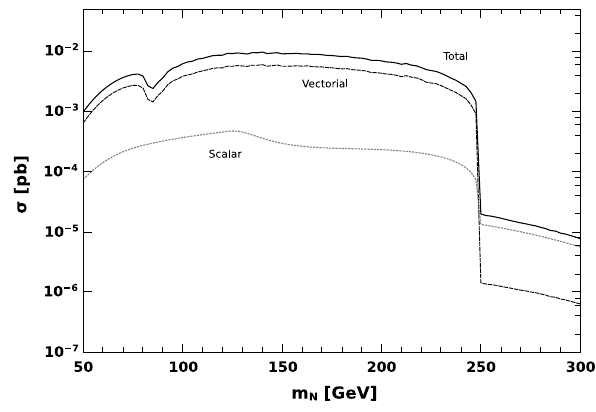
Fig. 5 Cross section for the process e + e − → l + l + + 4j